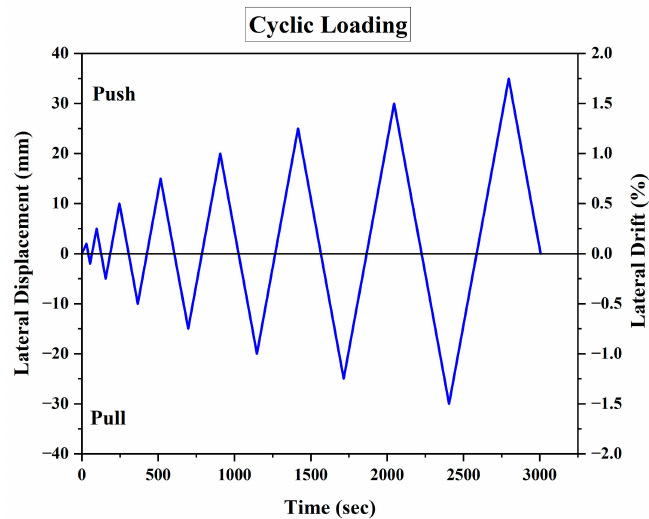
Figure 3. Quasi-static cyclic displacement time